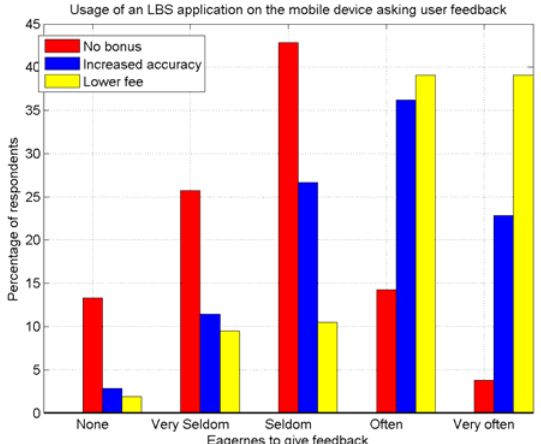
Figure 10. Willingness to give feedback regarding the location accuracy, conditioned to some